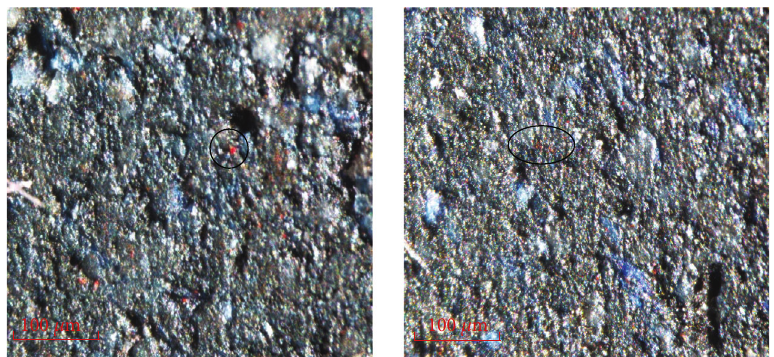
Figure 5: Local enlarged view of core slice A-1 after oil displacing manganese water.